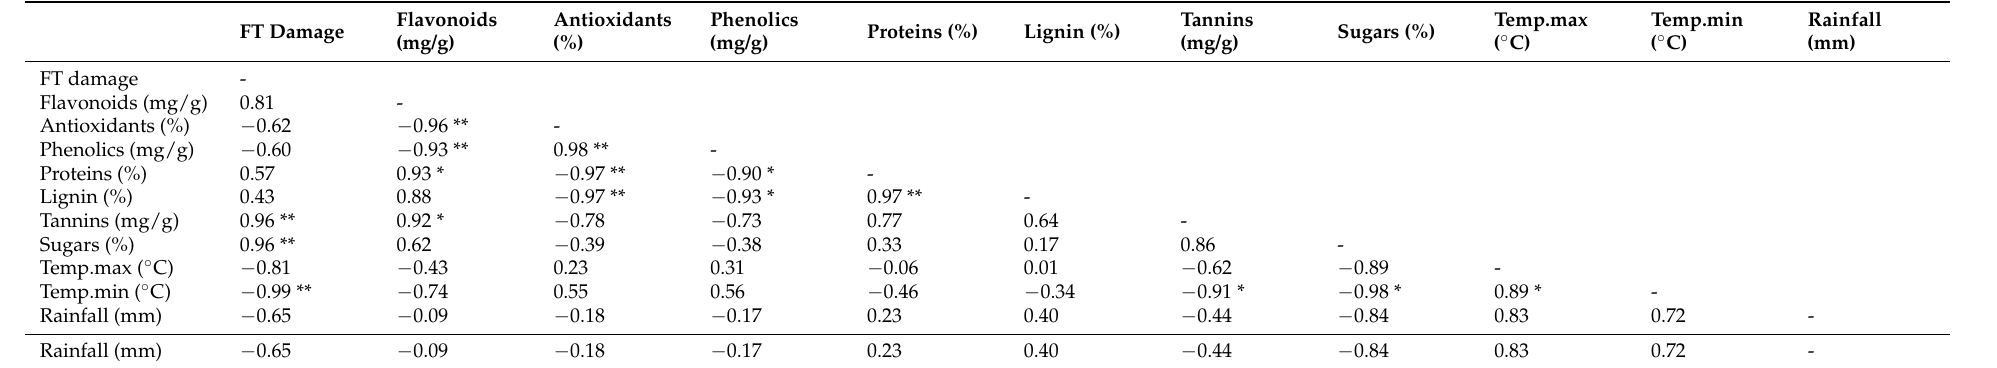
Table 4. Correlation coefficients for the cowpea genotypes screened for secondary metabolites and flower thrips across four